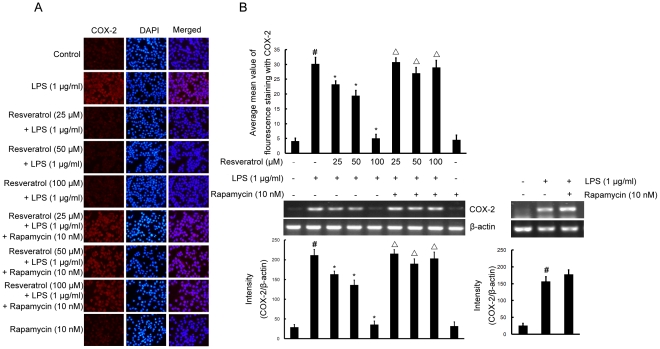
mTOR is required for resveratrol-inhibited expression of COX-2 protein and mRNA induced by LPS in BV-2 cells.Panel A shows the immunofluorenscence images for protein expression of COX-2 and Panel B shows the corresponding mRNA data. The relative mRNA level was quantified by scanning densitometry and normalized to β-actin mRNA. Note the up-regulated protein and mRNA expression of COX-2 by LPS is suppressed by different concentrations of resveratrol; however, in cells pretreated with mTOR inhibitor rapamycin, the suppressive effect of resveratrol is abrogated. The values shown are mean ± SEM of data from three independent experiments. #Significant compared with control alone, p<0.05. *Significant compared with LPS alone, p<0.05. ▵Significant compared with resveratrol+LPS, p<0.05.